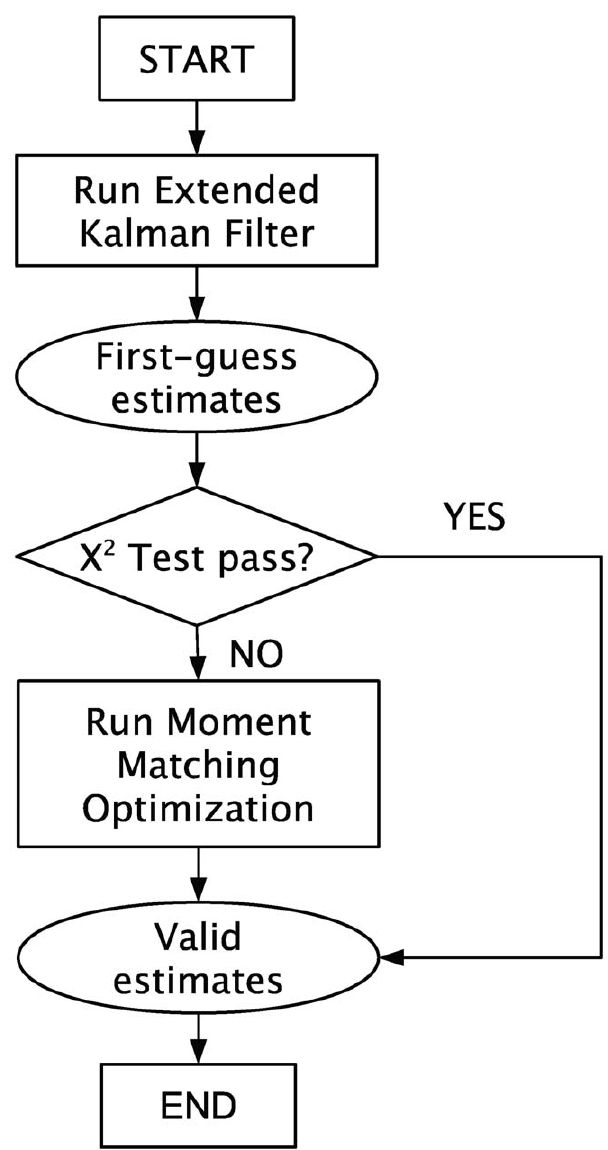
Figure 1. Flowchart of the proposed method. The algorithm is a three-stage process, which involves Kalman filtering, a statistical accuracy test and an optimization problem.